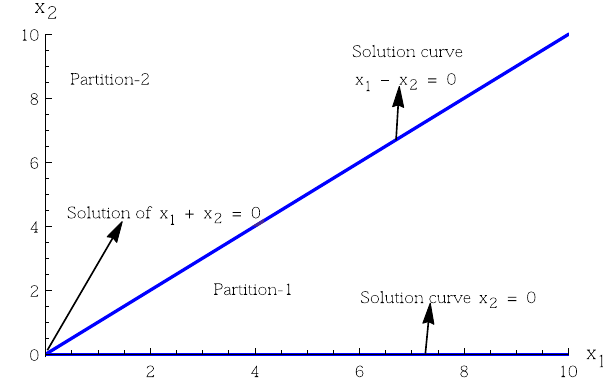
Fig. 6 Partitioning of alpha parameter space by solution curves of the Gröbner basis